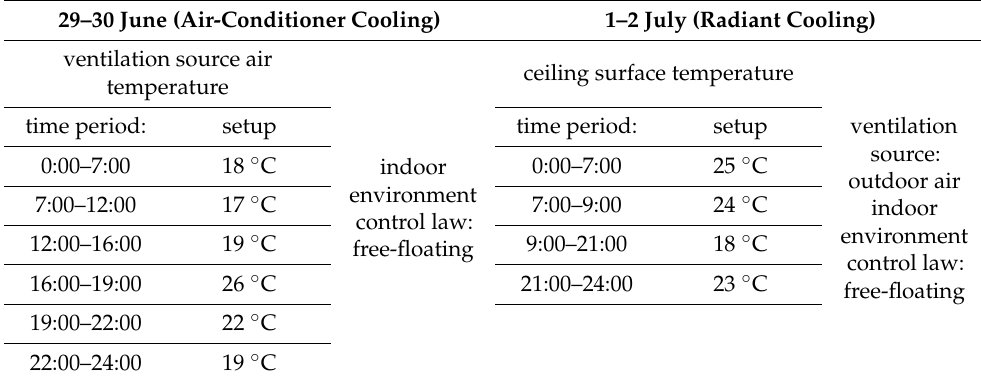
Table 3. Simulation model setup